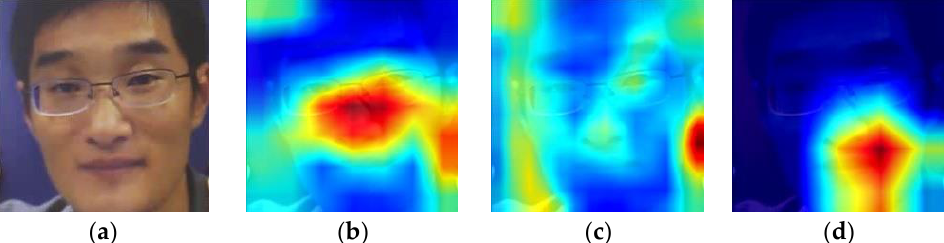
Figure 9. The visualization results of photo face in the last layer network. ( a ) Original. ( b ) ResNet50. ( c ) VGG16. ( d ) InceptionV3.